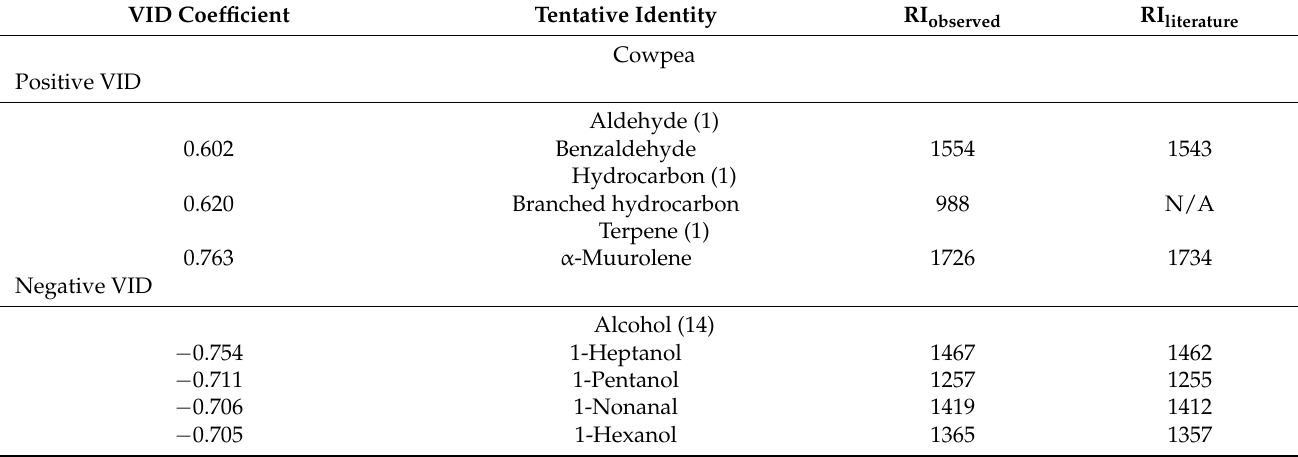
Table 2. Discriminant volatile compounds changing as a function of hydrothermal processing time ( t c ) in opened (home) processing of cowpeas, chickpeas and kidney beans as tentatively identified by NIST spectra, matching with the literature retention index (RI), and authentic